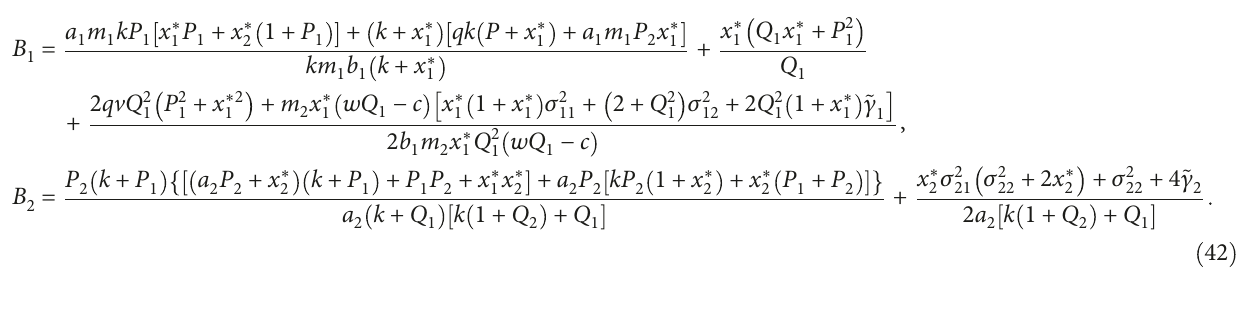
Figure 1: Parameter values are given as follows: r = 0 j , k = 1, 2 and γ When σ jk is locally asymptotically stable around 4 5384, 1 7647, 0 0231 and (b) τ 1 = 1 4451 , τ 2 = 2 92 , and system (21) is unstable stable around 4 5384, 1 7647, 0 0231